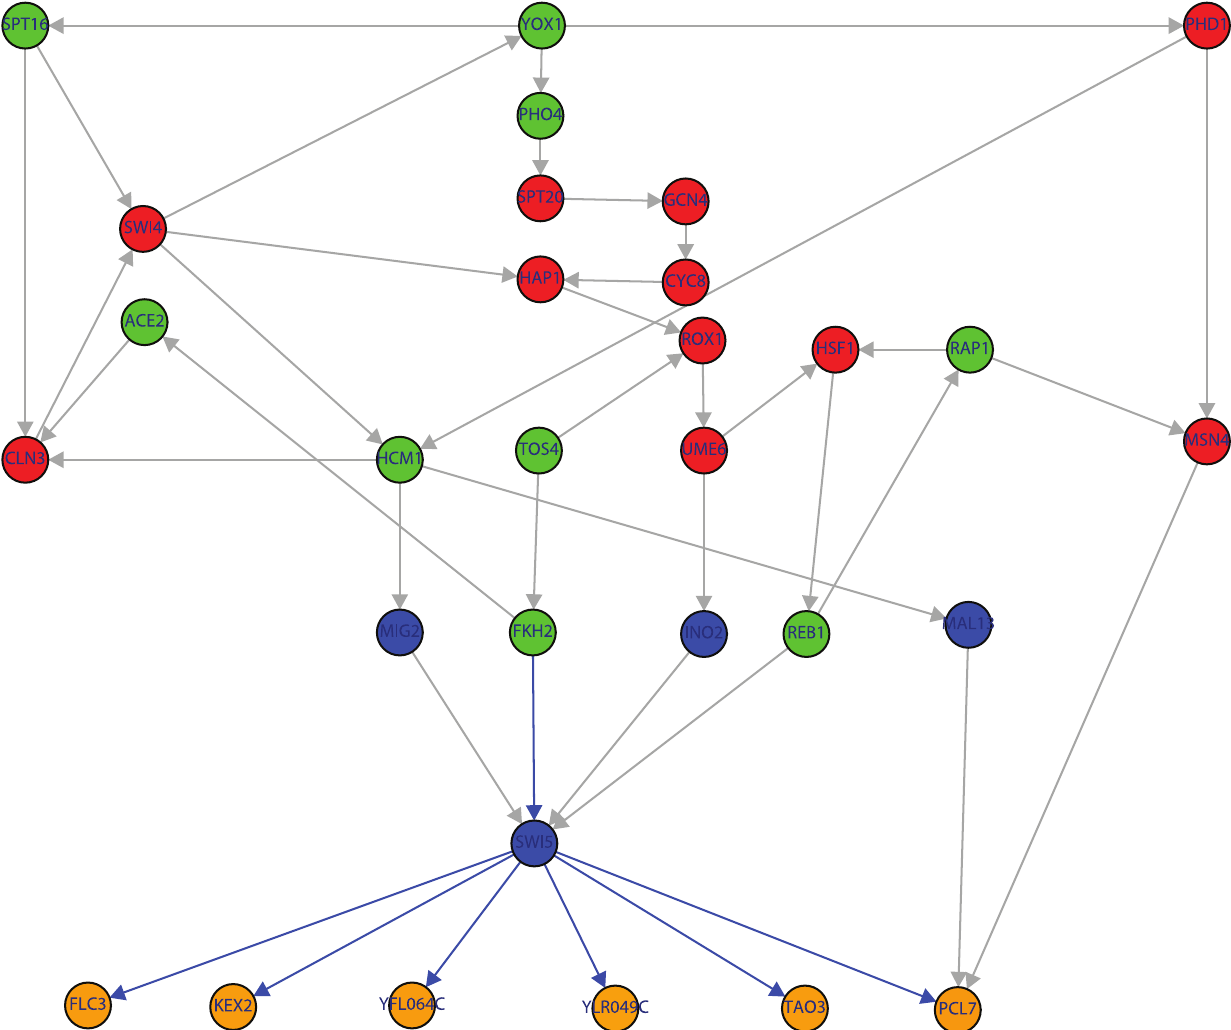
Figure 8. Subnetwork of the TRN of yeast containing 30 genes. Color code of the nodes is as in Fig. 1. The shown subnetwork complements the results in table 1 by providing detailed information about the genes involved in the shortest paths. The blue edges indicate the shortest path connecting FKH2 R SWI5 R FLC 3, KEX 2, YFL 064 C , YLR 049 C , TAO 3, PCL 7 f